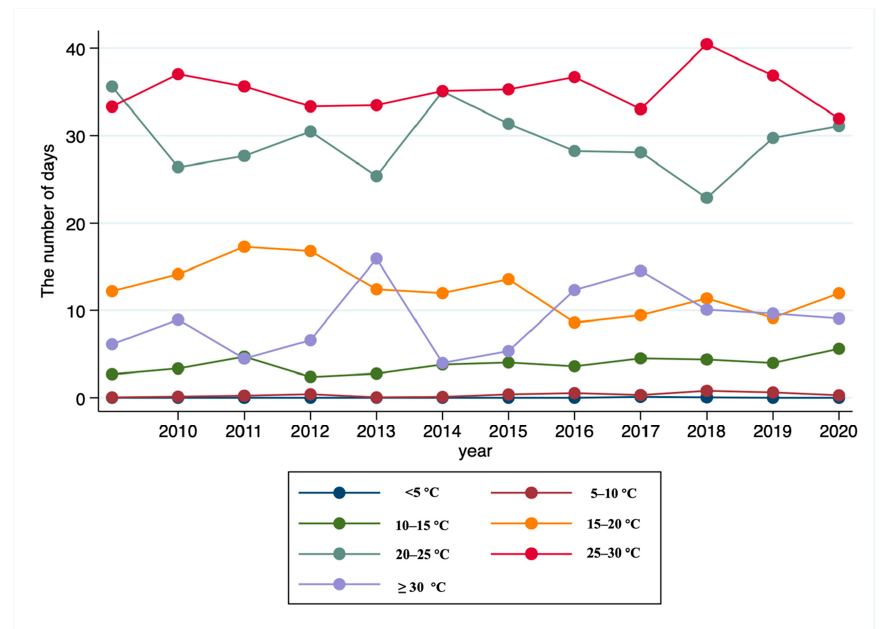
Figure 2. Distribution of daily average temperature in the previous three months in the estimation sample.